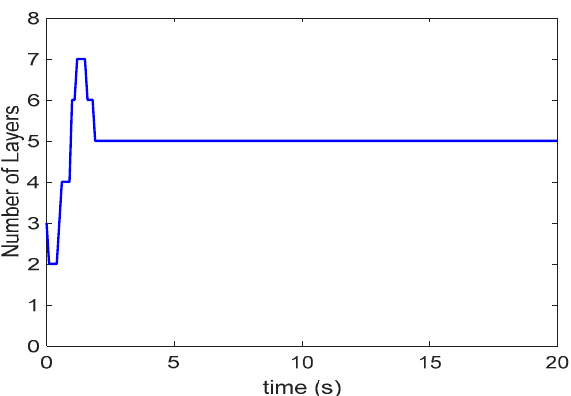
Figure 16. Number of layers using self-evolving algorithm for Case 2.